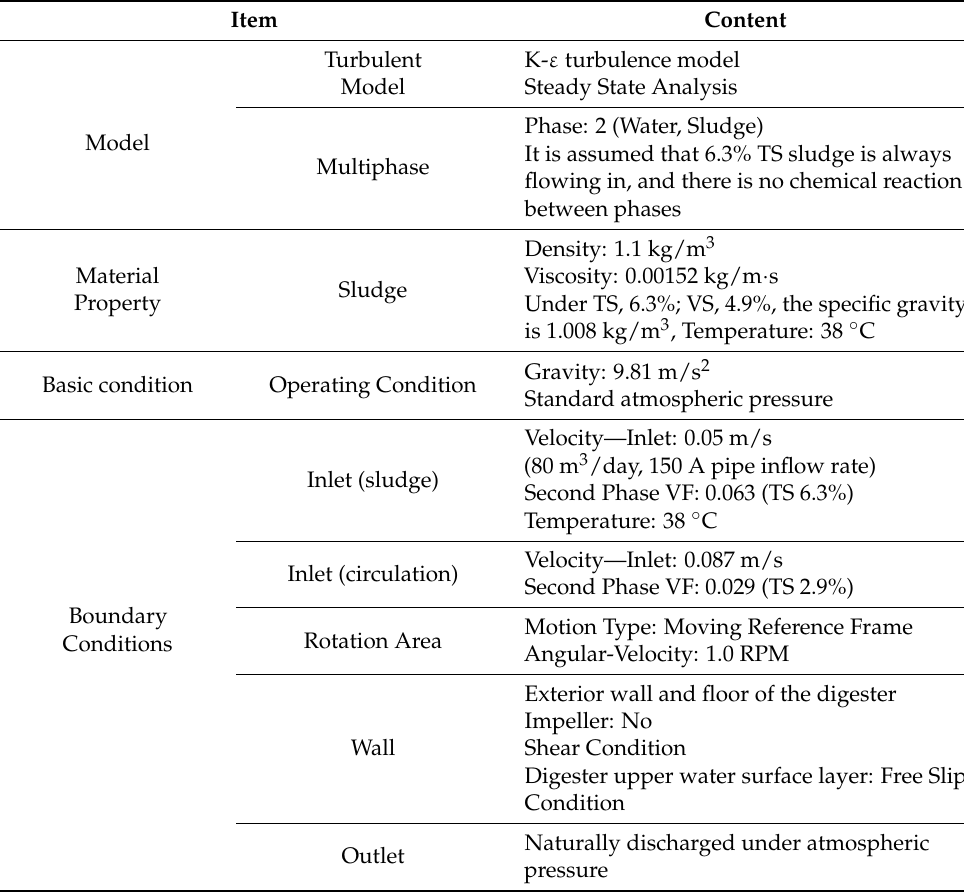
Table A1. Application model parameters and boundary